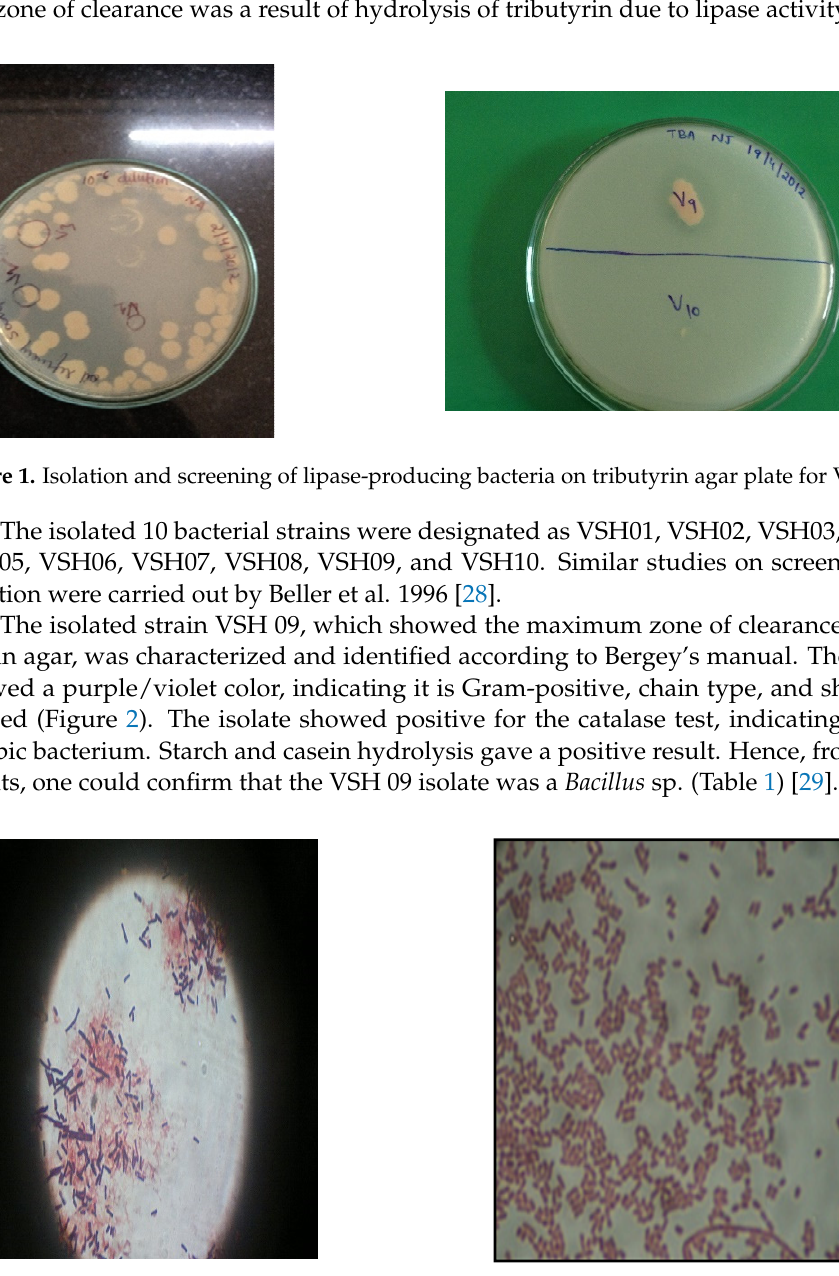
Figure 2. Gram stain of bacterial isolate VSH 09 showing the crystal violet color and bacilli shape. Table 1. Morphological and biochemical characterization of bacterial isolates.